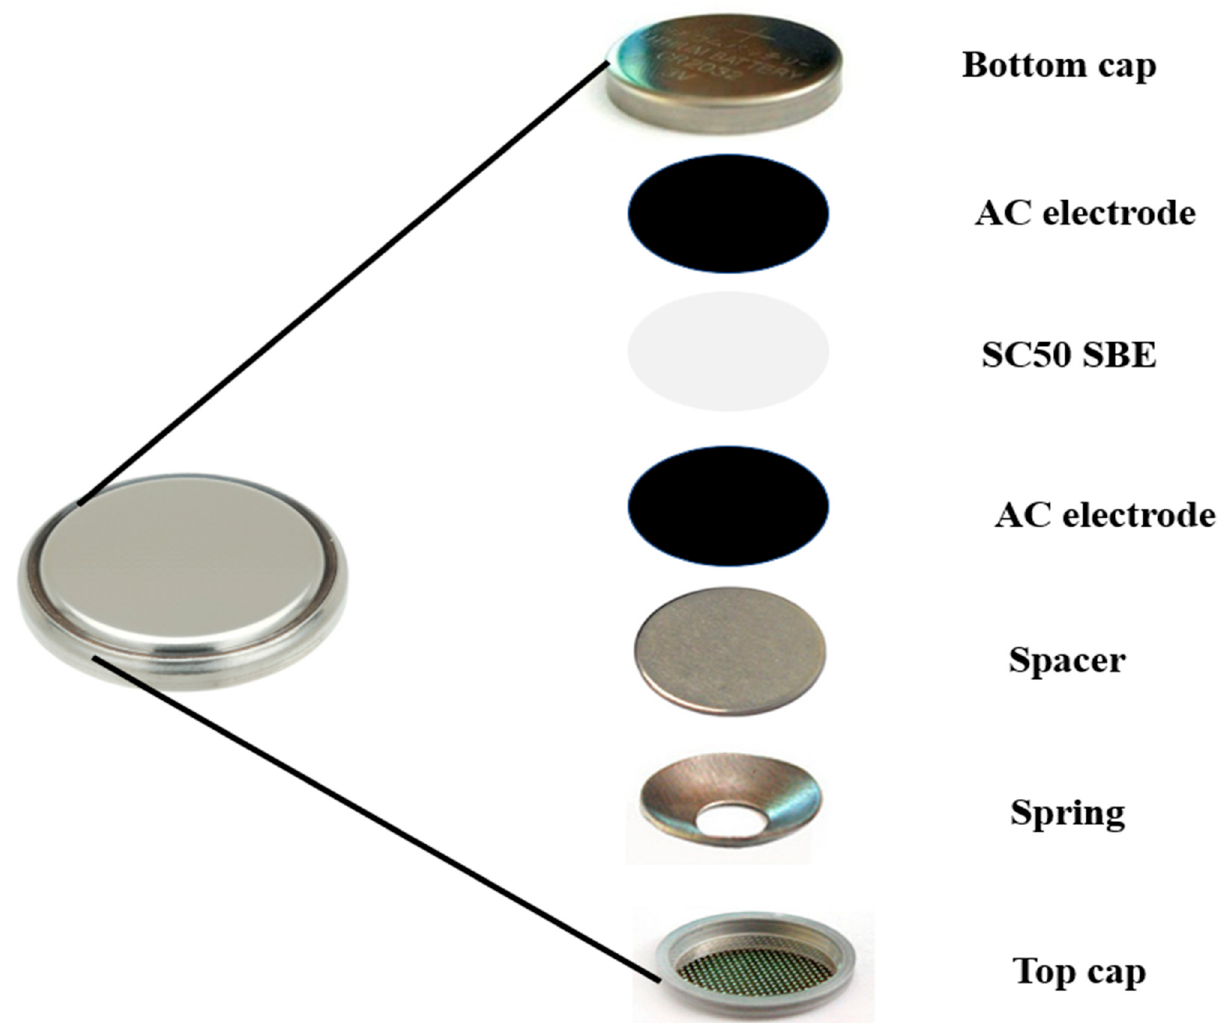
Figure 9. Illustration of EDLC fabrication using CR2032 coin cell assembly.